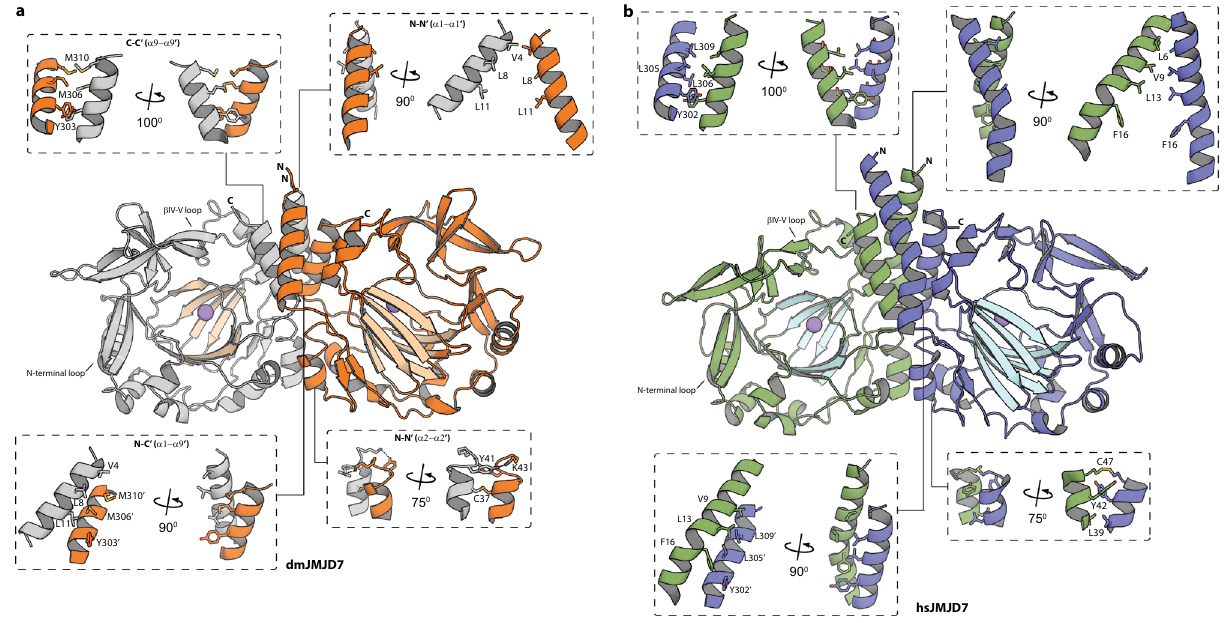
Figure 3. Both dmJMJD7 and hsJMJD7 are dimeric 2OG-oxygenases. Structural analysis of the oligomerization domains of Drosophila ( A ) and human ( B ) JMJD7 reveals a conserved role for α-helices in oligomerization between monomers, which is reminiscent of dimerization in FIH and TYW5 2,3 , though the nature of the interactions differs. While FIH and TYW5 employ C-terminally located α-helices for dimerizations, JMJD7 dimerizes via a mode involving both N- (α1 and α2) and C- (α9) terminal α-helical regions (see text for